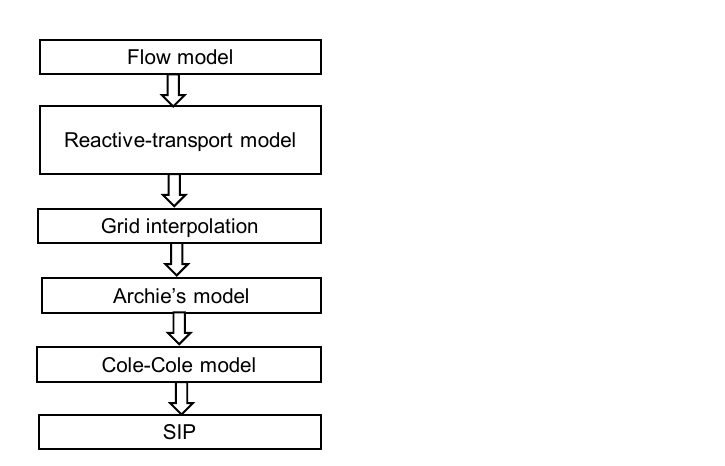
Figure 1. Coupling PFLOTRAN and spectral induced polarization (SIP) Process Models: Steps involved in coupling fluid flow, solute transport, and SIP process models in the PFLOTRAN-SIP framework. Details of the inputs, data, process models, and outputs are described in Algorithm